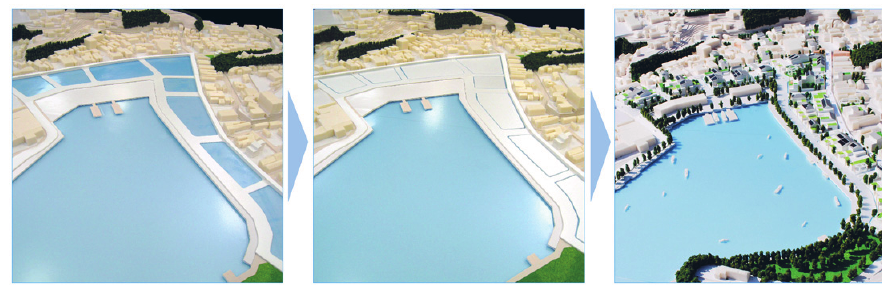
Figure 15. Different construction stages of Kesennuma Bay